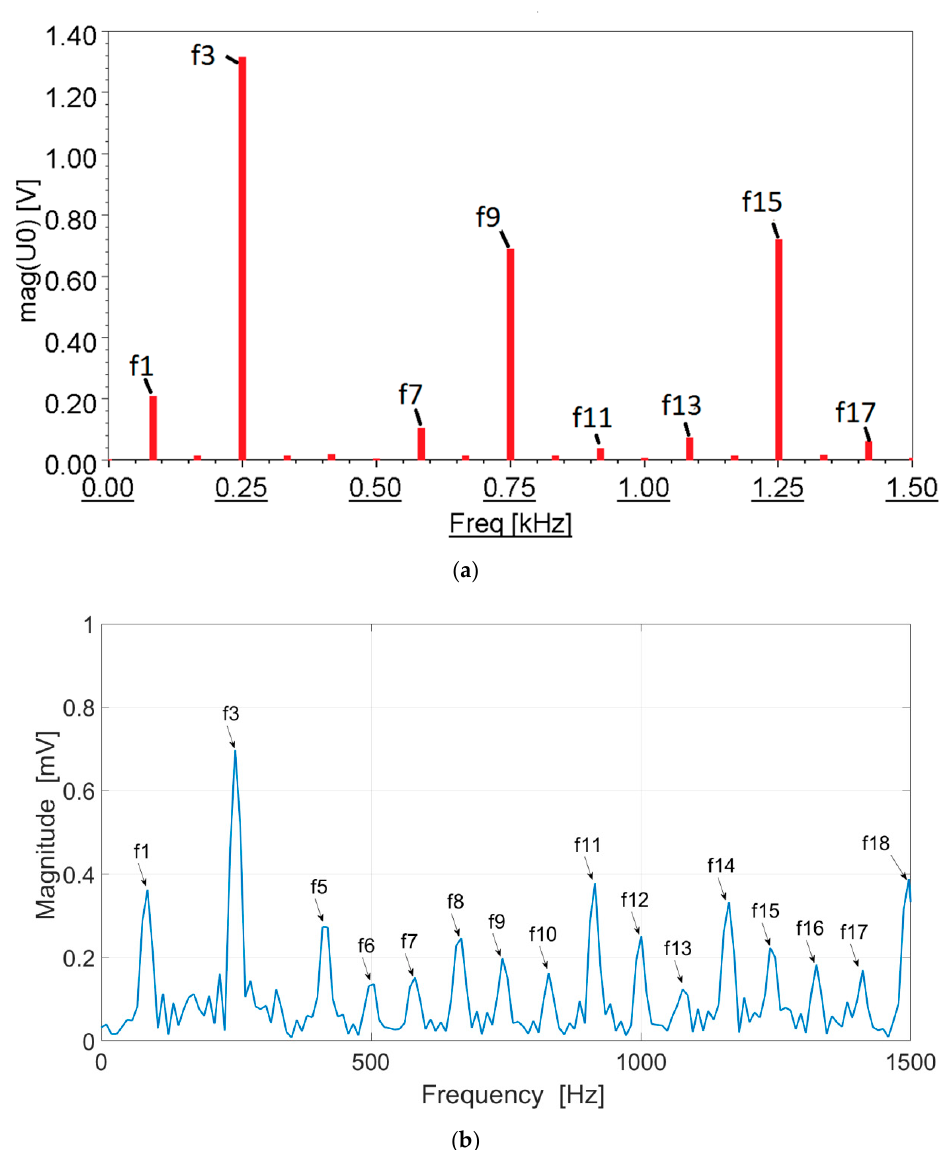
Figure 23. Star–delta (Y ∆ ) configuration—FFT of neutral voltage u 0 in fault state OC2: ( a ) numerical calculations; ( b ) measurements.